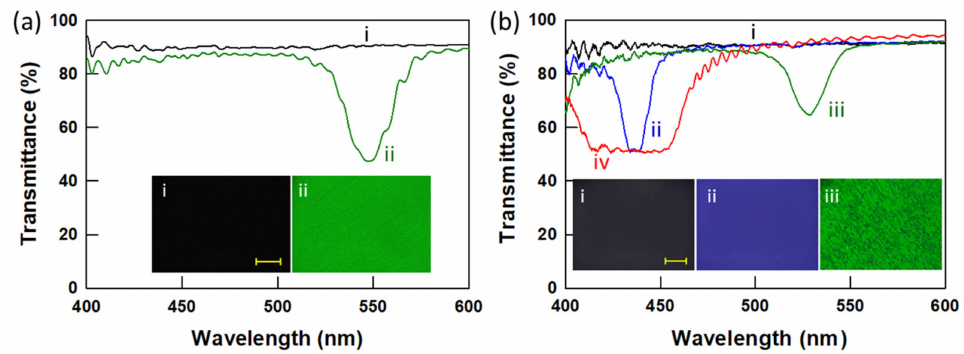
Figure 3. Transmission spectra and POM images of ( a ) BPLC-4 at ( i ) 36.5 ◦ C (isotropic) and ( ii ) 25 ◦ C (BP-I) and ( b ) BPLC-4-C6M at ( i ) 48 ◦ C (isotropic), ( ii ) 46 ◦ C (BP-II), ( iii ) 42 ◦ C (BP-I), ( iv ) 24 ◦ C (CLC). Both samples were prepared in an aligned planar cell. BPLC-4 contains 5 wt% SL04151, 4 wt% PETA, 4 wt% R1011, 21 wt% R811 and 66 wt% E7. BPLC-4-C6M contains 5 wt% SL04151, 4 wt% C6M, 4 wt% R1011, 21 wt% R811 and 66 wt% E7. Scale bar in the POM image is 200 µ m. Cells of 11.3 µ m thickness were